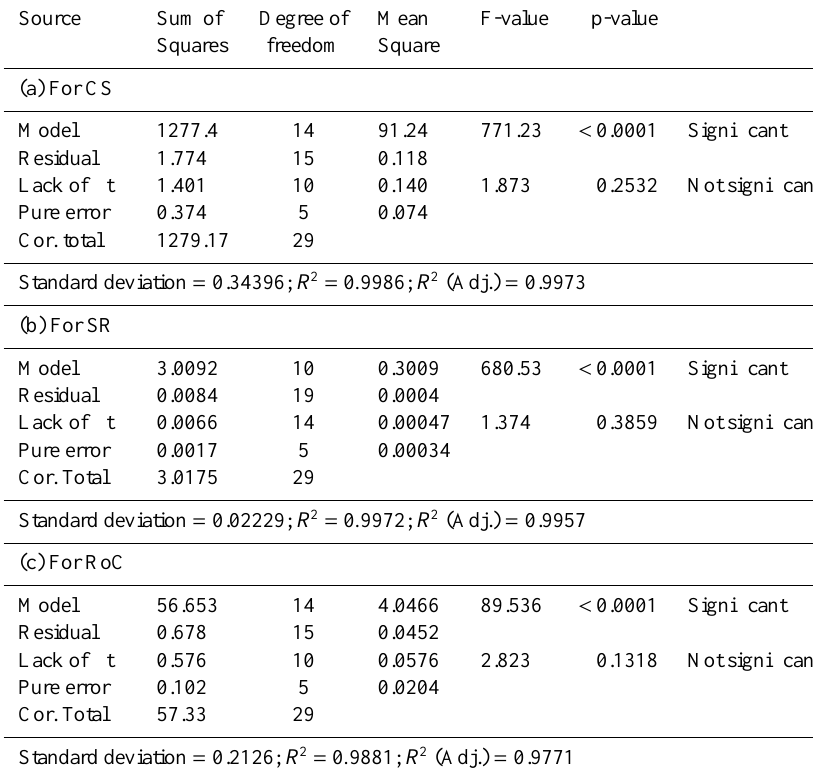
Table 3. The ANOVA table for fitted models. Source Sum of Degree of Mean F-value p-value Squares freedom Square